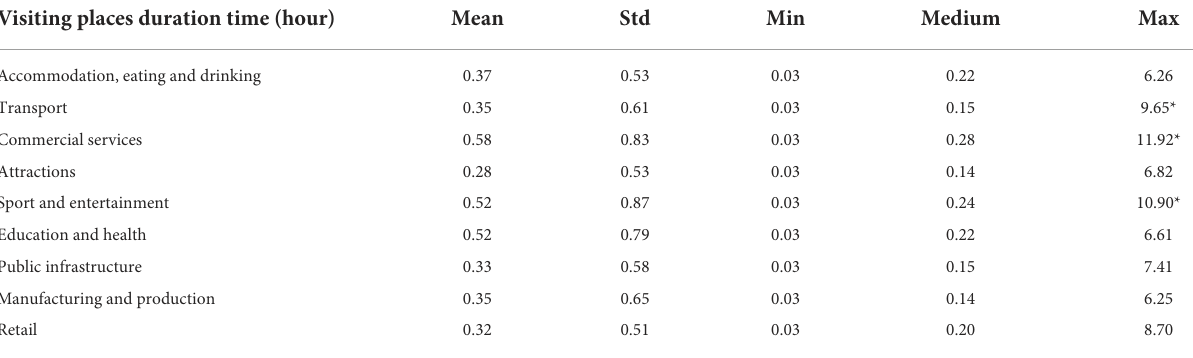
TABLE 5 Statistical description of individual’s visit duration time at places during the whole observation